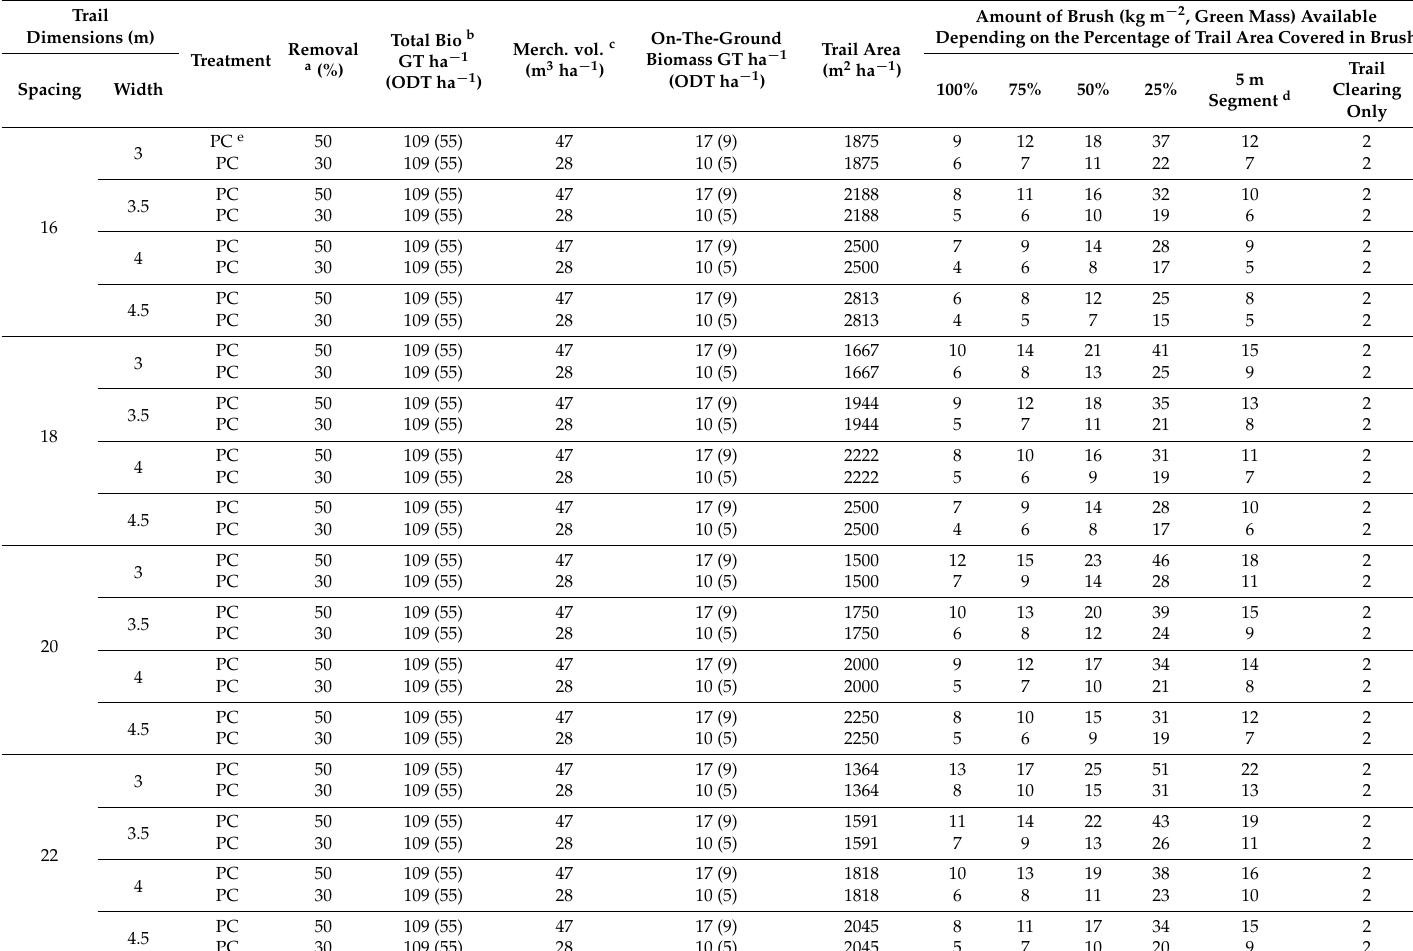
Table A3. Amount of brush available for soil protection as brush mats depending on trail spacing, trail width and varying trail coverage obtained from a an artificially regenerated high-yield white spruce stand